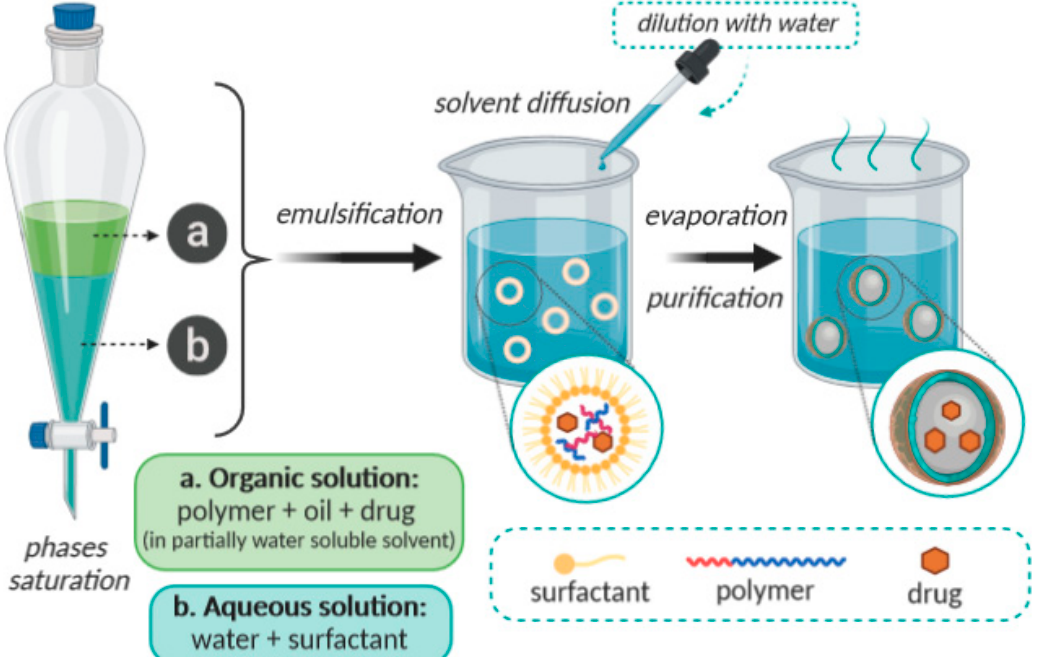
Figure 3. Schematic representation of the emulsification/solvent diffusion method.